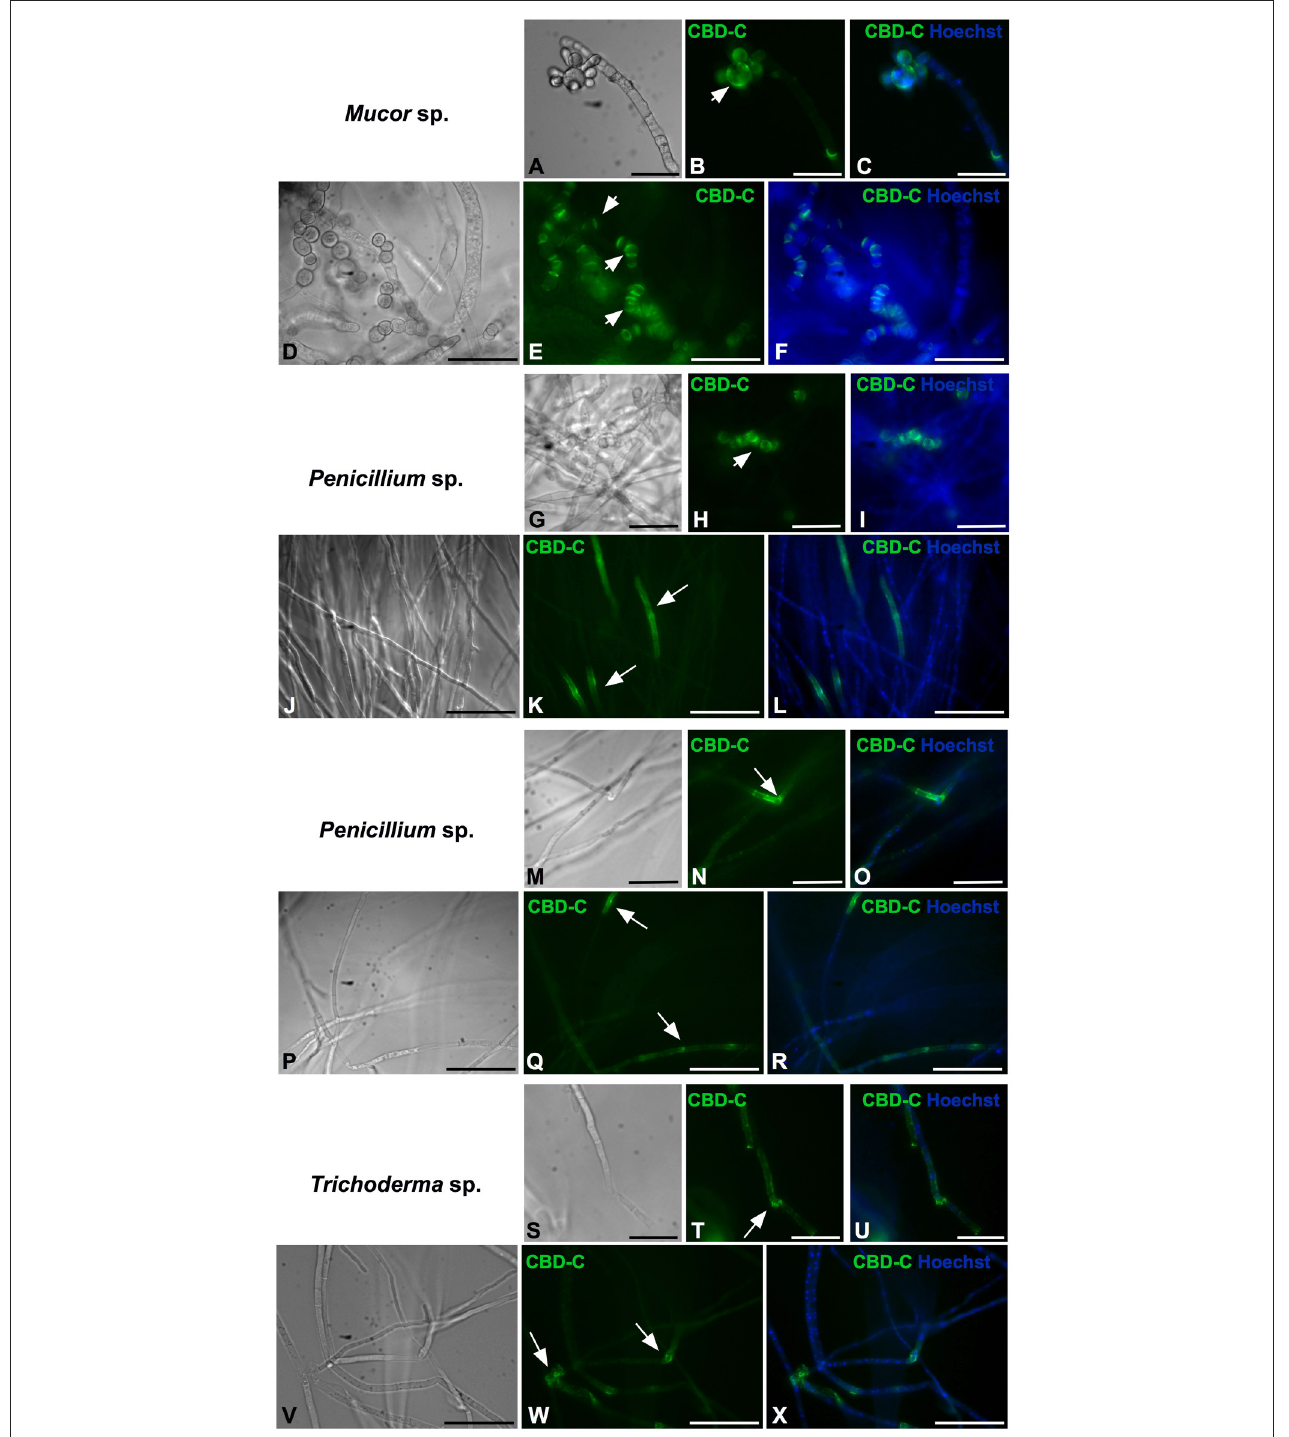
FIGURE 3 | Immunofluorescence with the Fc-CBD-C probe on whole fungi grown in liquid medium. Fungal species, Mucor sp. (A–F) , Penicillium spp. (G–R), and Trichoderma sp. (S–X) , were grown in liquid medium and characterized by immunofluorescent staining with the Fc-CBD-C probe. In Mucor sp., CBD-C binds fungal spores ( B,E , arrowheads); in Penicillium spp., CBD-C recognizes chitin in specific regions of the hyphae ( K,N,Q, arrows) and in some cases fungal spores ( H, arrowhead); in Trichoderma sp., chitin fibers are apparent in specific regions of the hyphae ( T,W , arrows). (A,D,G,J,M,P,S,V) represent brightfield images; (C,F,I,L,O,R,U,X) represents merged images of the Fc-CBD-C probe (green) and nuclear staining with Hoechst (blue). Scale bars: (A–C,D–F,J–L,P–R,V–X) , 50 µ m; (G–I,M–O,S–U) , 25 µ m.